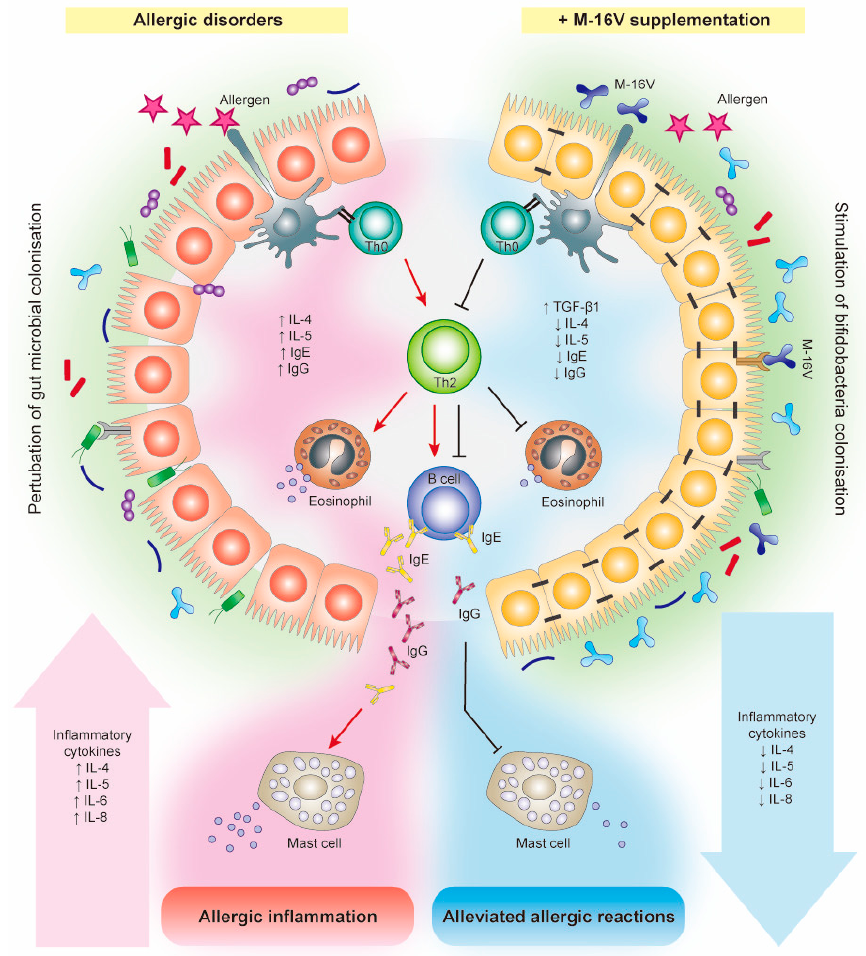
Figure 2. Bifidobacterium breve M-16V could potentially promote bifidobacterial colonisation and